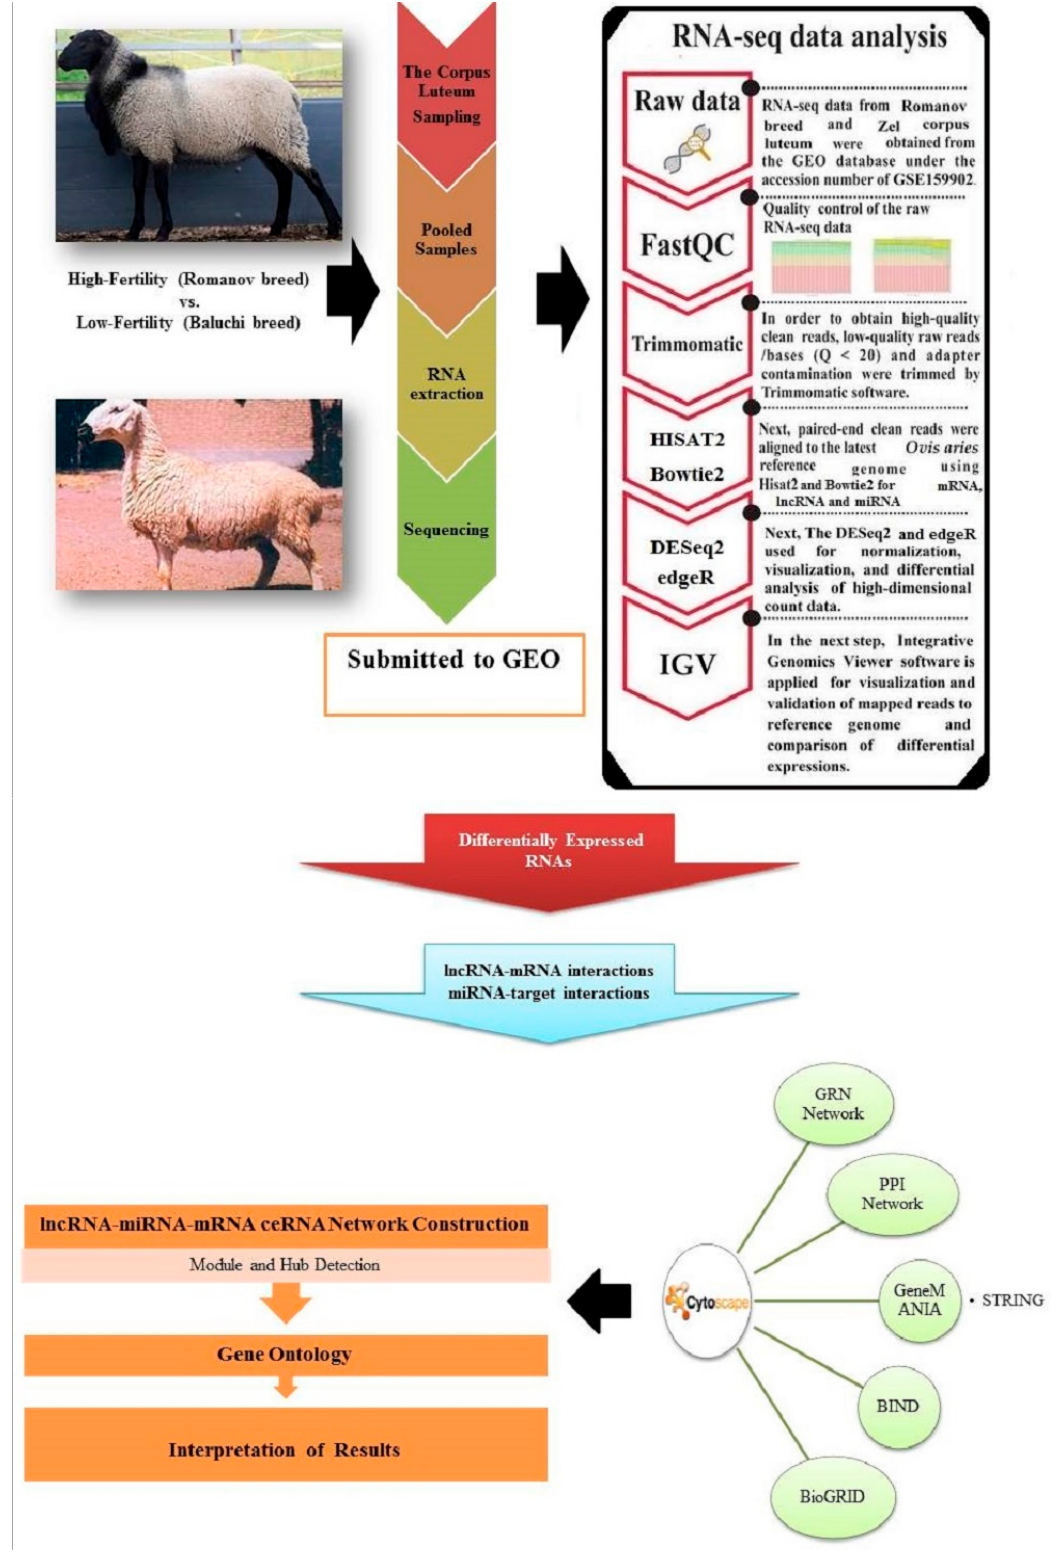
Figure 1. Schematic of the pipeline used to construct lncRNA–miRNA–mRNA ceRNA network of the corpus luteum in sheep. The main RNAs were identified from the RNA-Seq dataset between two different breeds. The protein–protein interaction network (PPI) and gene regulatory network (GRN) were constructed and visualized using Cytoscape